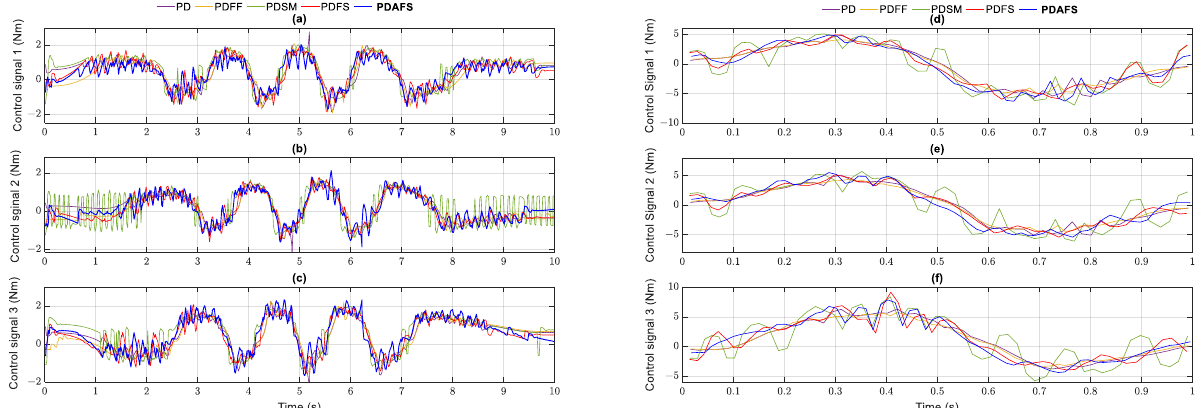
Figure 15. Control signals generated by the controllers in the helix and parabolic of case 1: ( a ) joint 1; ( b ) joint 2; ( c ) joint 3 in the helix trajectory; ( d ) joint 1; ( e ) joint 2; ( f ) joint 3 in the parabolic trajec- tory.